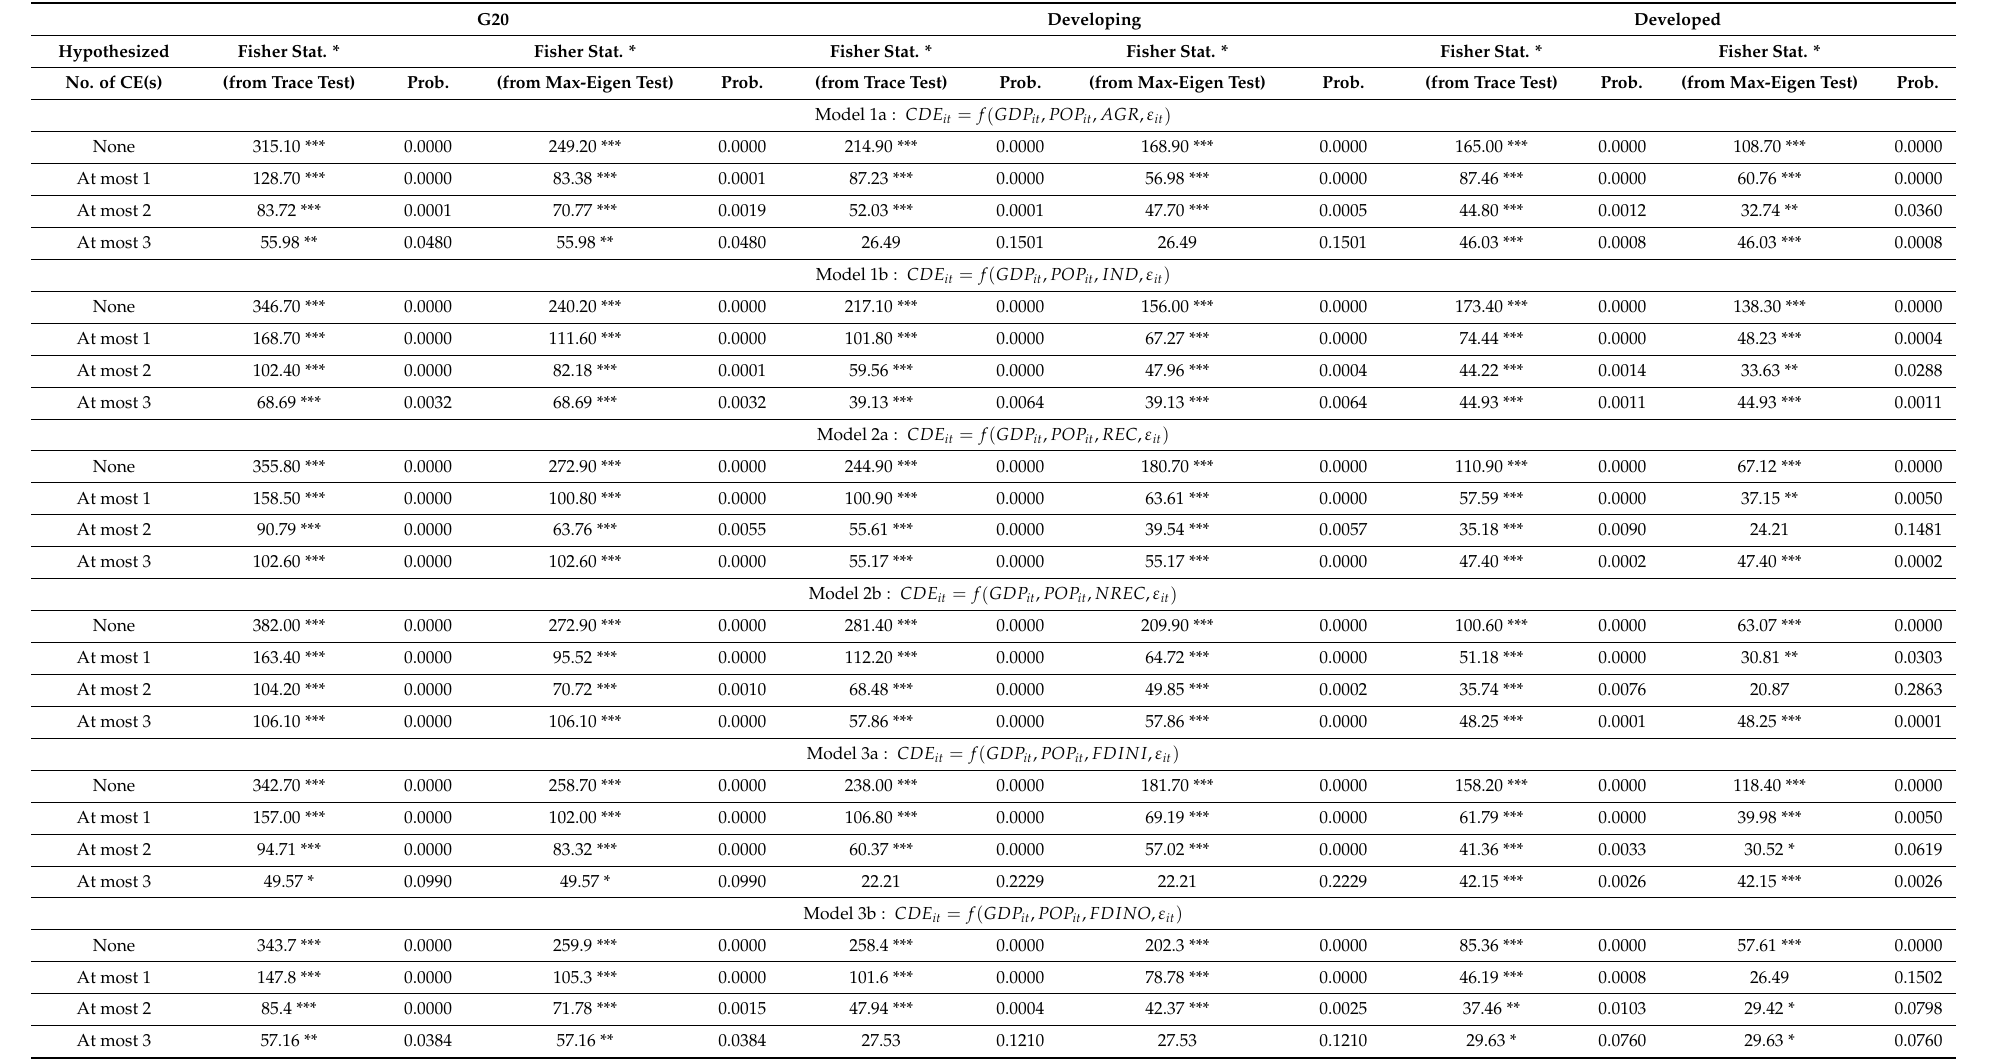
Table 6. Johansen Fisher panel cointegration